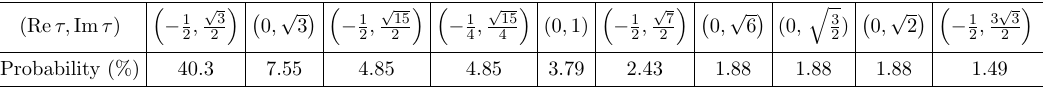
Table 3 . Probabilities of the stable vacua as functions of (Re (cid:28); Im (cid:28) ) in the descending order of the probability for N max = (cid:13)ux